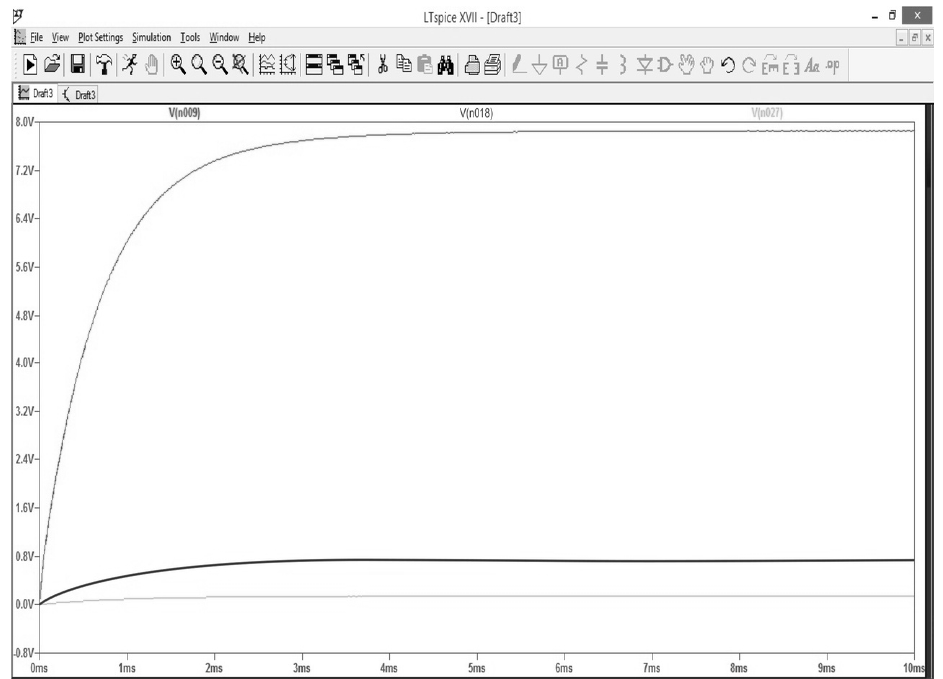
Fig. 2. Input and output